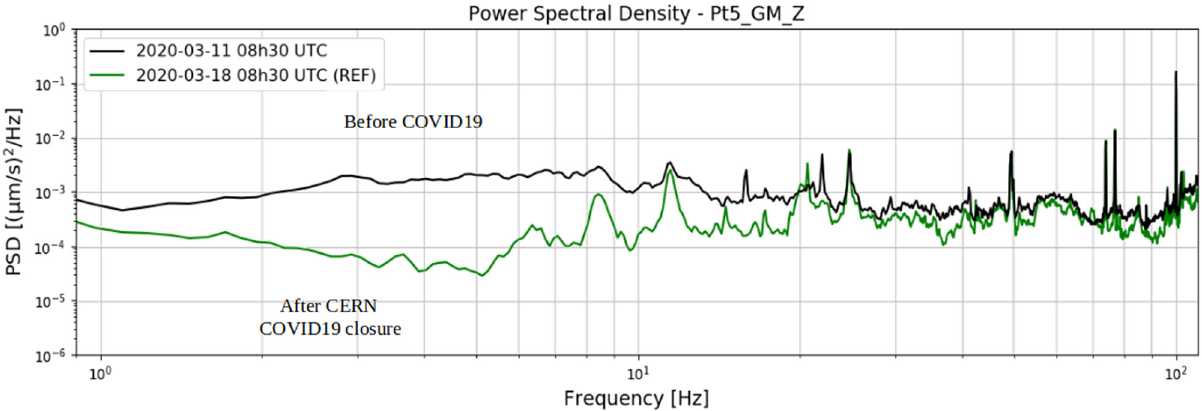
Figure 6: PSD graph for the 20 - min data block from the seismic station at LHC tunnel ( CERN Point 5 – CMS ) before ( black line ) and after ( green line ) COVID - 19 CERN closure.